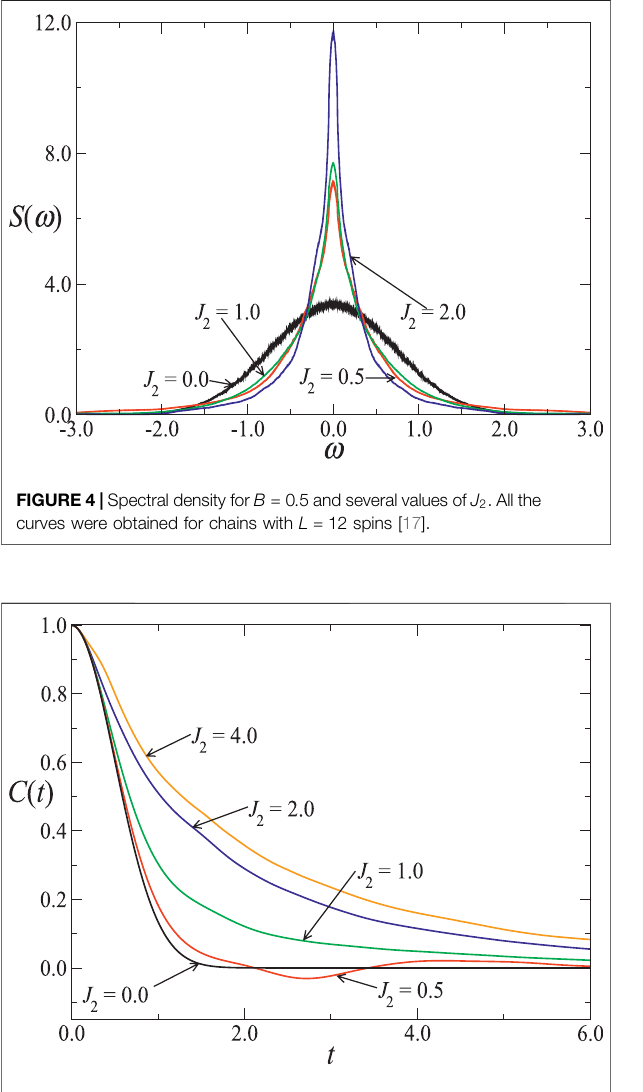
FIGURE 5 | Time-dependent correlation function for B (cid:2) 1 and several values of J 2 . The curves were obtained with L (cid:2) 12 and 13. See Ref. 17.